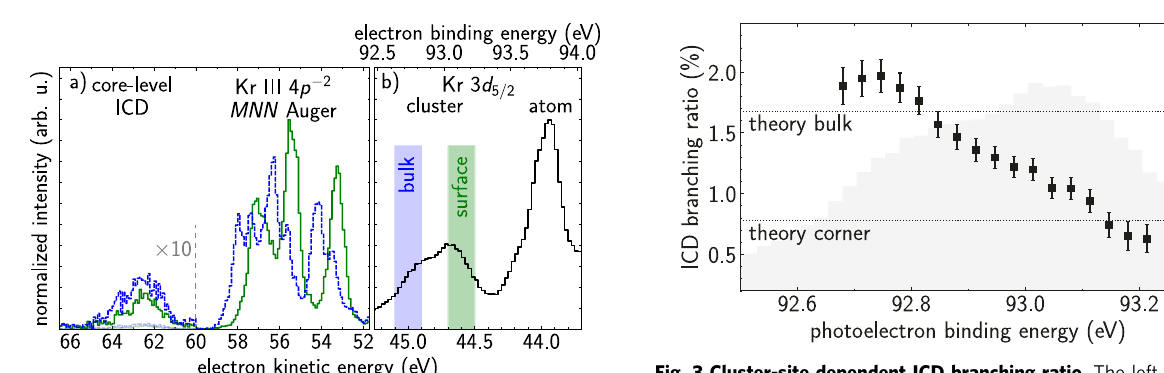
the absolute scale is not shown due to unknown uncertainties from used literature values. The two black dotted lines indicate the theoretically calculated values for the ICD branching ratio of bulk and corner atoms. The shaded area).